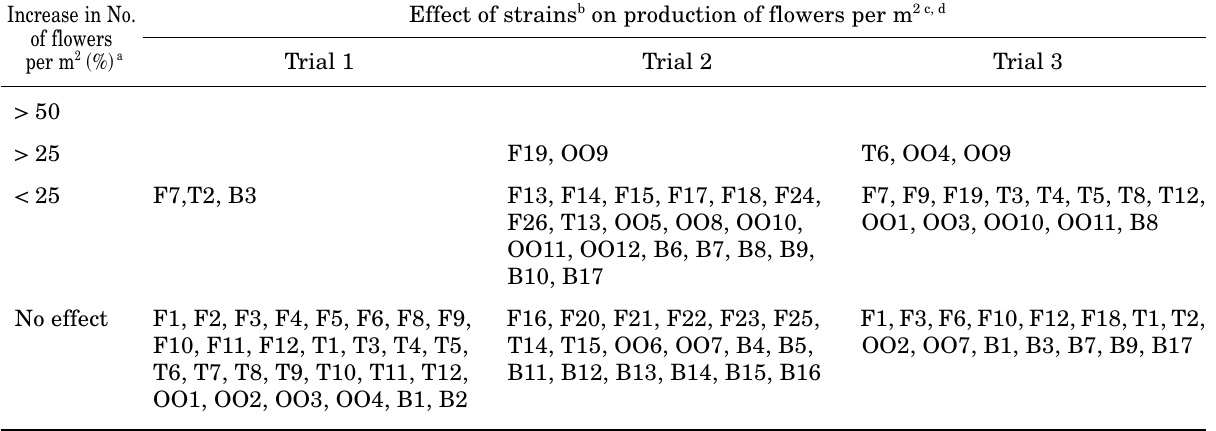
Table 5. The effect of selected strains of Fusarium , Trichoderma , oomycetes and bacteria applied by soil mixing (fungi) or root dipping (bacteria), on production of flowers per m 2 in gerbera plants grown in open soilless systems (first and second trial, Albenga, 2000; third trial, Albenga, 2001). Increase in